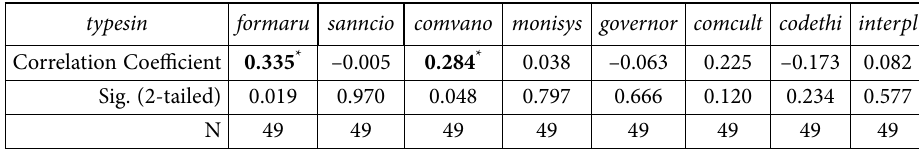
Table 5. Spearman’s rho correlation – H2 (source: authors’ compilation)